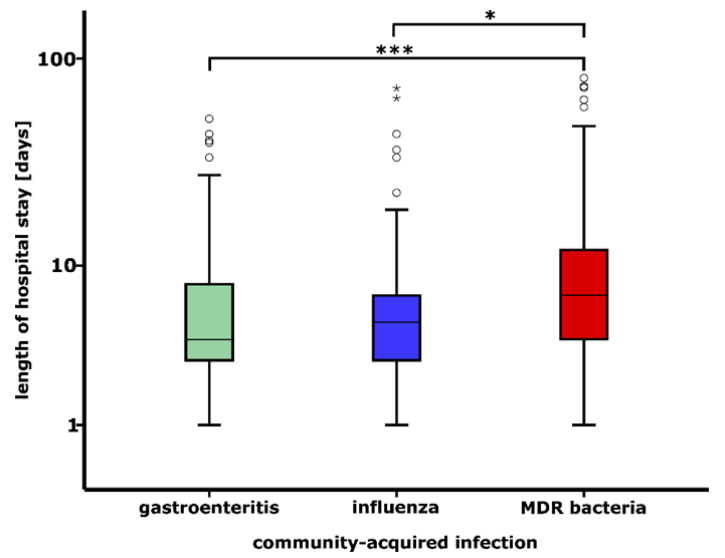
Figure 2. Distribution of length of hospital stay of patients with community-acquired gastroenteritis, in- fluenza and multidrug-resistant infections detected at the University of Debrecen Clinical Centre Nagyerdei Campus in 2020. Median, interquartile ranges and 1.5 times of interquartile ranges as whiskers are shown. Open circles and asterisks indicate outlier values. * p < 0.05, *** p < 0.001. Gastroenteritis includes patients with community-acquired Clostridioides difficile, Campylobacter sp., Salmonella sp. and Rotavirus infections. Influenza includes patients with community-acquired Influenza A and B viruses infections. MDR bacteria includes patients with community-acquired Methicillin-resistant Staphylococcus aureus , Vancomycin-resistant Enterococcus spp., Multidrug-resistant (MDR) Acinetobacter baumannii , MDR Escherichia coli , MDR Enterobacter spp., MDR Klebsiella spp., MDR Pseudomonas aeruginosa , MDR Proteus mirabilis , MDR Citrobacter freundii